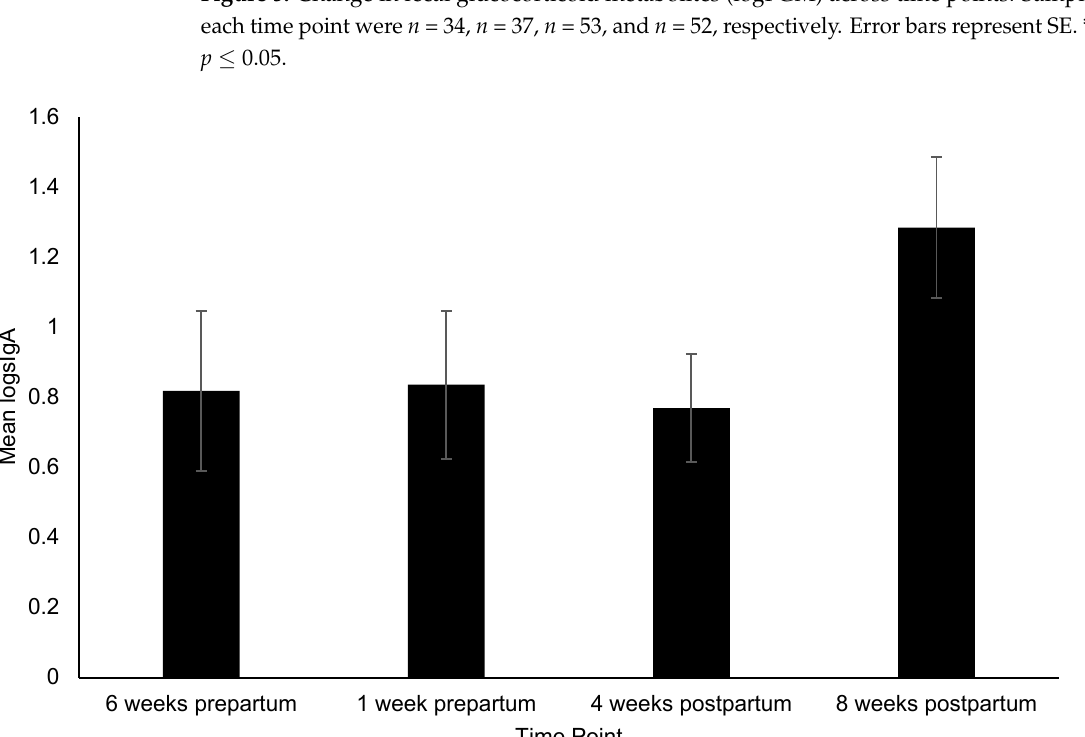
Figure 6. Change in fecal secretory immunoglobulin A (logsIgA) across time points. Sample sizes for each time point were n = 34, n = 37, n = 53, and n = 51, respectively. Error bars represent SE.